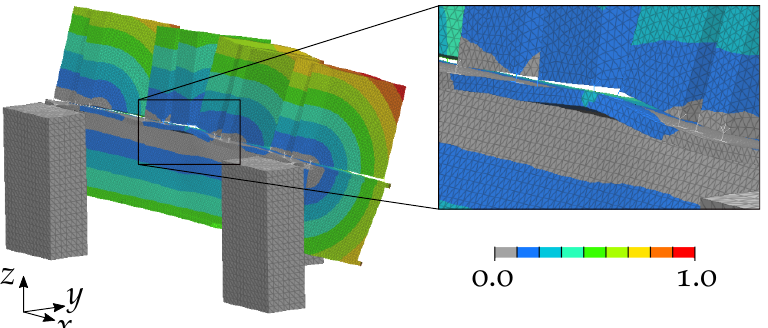
Figure 15. First mode shape of the PETRA III girder with magnets positioned individually 15 mm above the upper girder surface. The detailed view shows local deformations of the upper girder surface. The colors represent the normalised vibration amplitude.